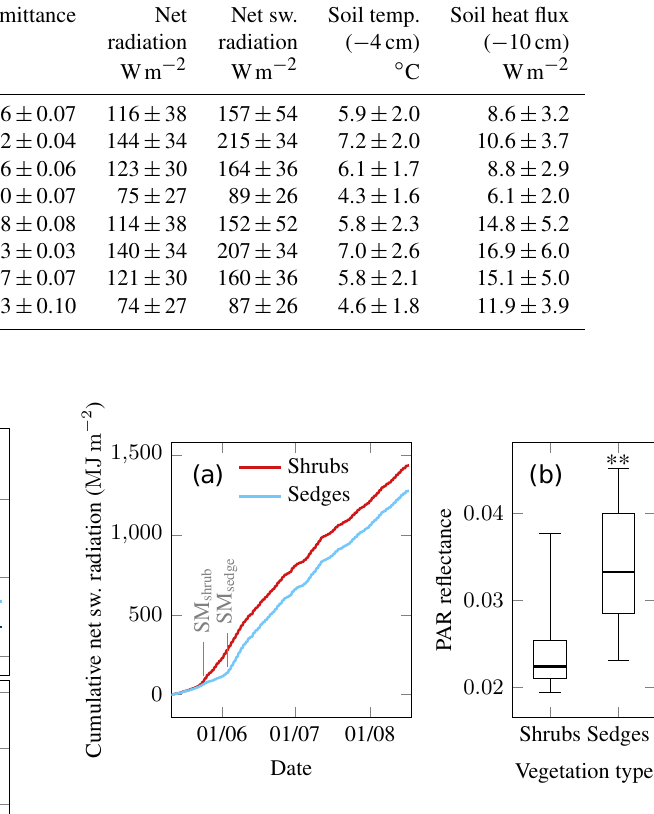
Figure 7. (a) Cumulative net shortwave (sw.) radiation 11 May–16 August 2014, day of complete snowmelt (SM) indicated for dwarf shrubs and wet sedges and (b) spatial variability of PAR (400– 700nm) reflectance within vegetation type measured on 25 July 2013, percentiles (25, 50, and 75), minimum and maximum values of eight plots per vegetation type; significant differences between vegetation types are shown with ∗∗ ( p ≤